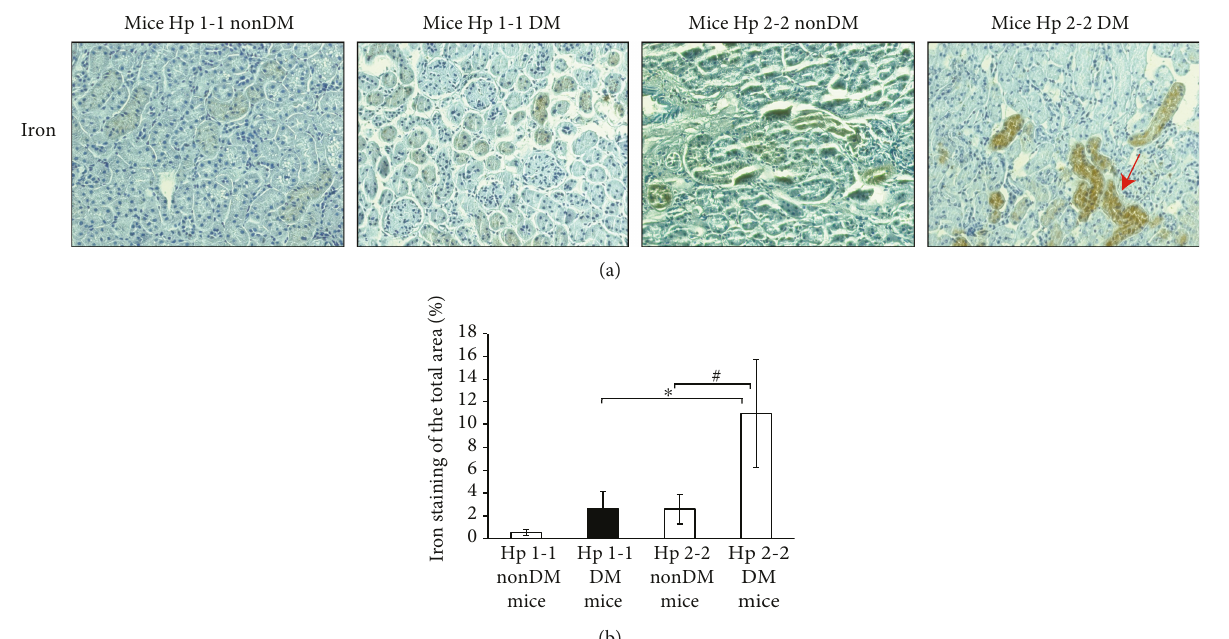
Figure 1: Iron staining in Hp 2-2 and Hp 1-1 renal sections of diabetic nephropathy and nondiabetic mice. (a) There was a signi fi cant increase of iron deposits represented by the DAB-enhanced Prussian blue staining (brown, indicated by a red arrow) in the proximal convoluted tubule (PCT) of Hp 2-2 diabetic (DM) sections compared with diabetic Hp 1-1 or with Hp 2-2 nondiabetic (nonDM) sections. (b) Quanti fi cation of the iron staining shows a signi fi cant increase in the percentage of the iron-stained area of Hp 2-2 DM mice compared with DN Hp 1-1 mice ( ∗ p < 0 001 ) or compared with nonDM Hp 2-2 mice ( # p < 0 001 ).